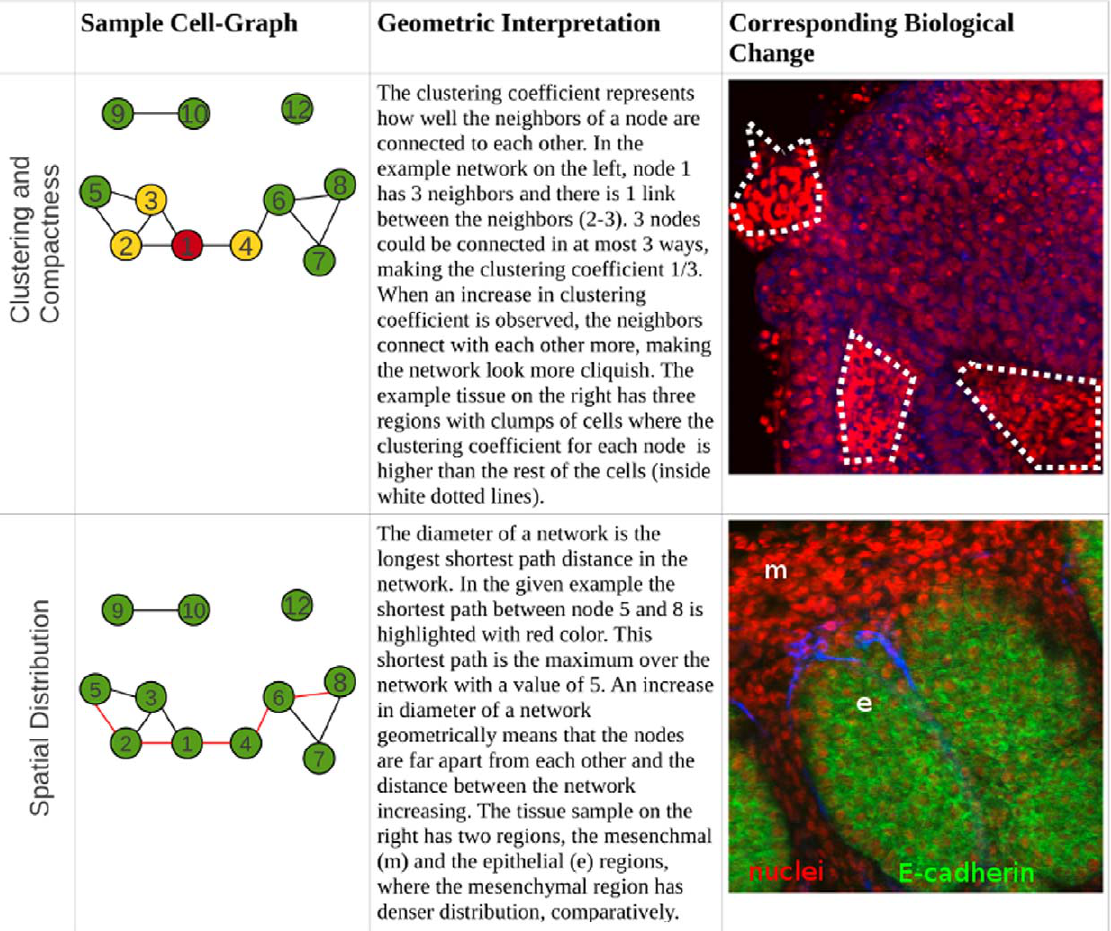
Figure 6. Geometric interpretation of changes in cell-graph features. A geometrical understanding of example cell-graph features is provided together with corresponding representative tissue samples. Geometrical interpretations of the changes for the example features are studied.